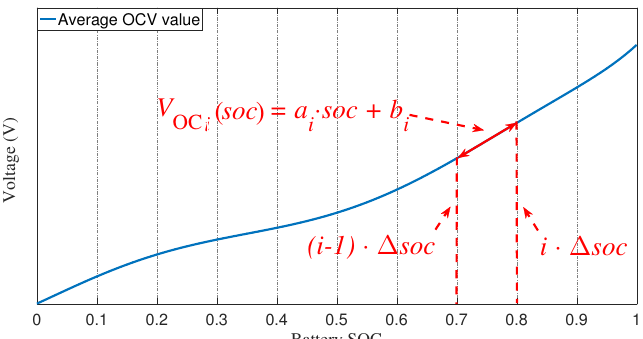
Figure 3. General form of the average open circuit voltage (OCV) curve (example adapted from [28], Copyright IEEE,